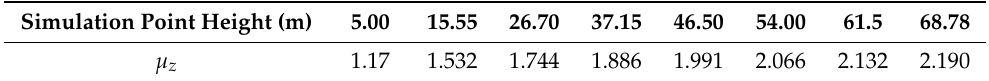
Table 4. Wind-pressure height-change coefficient.